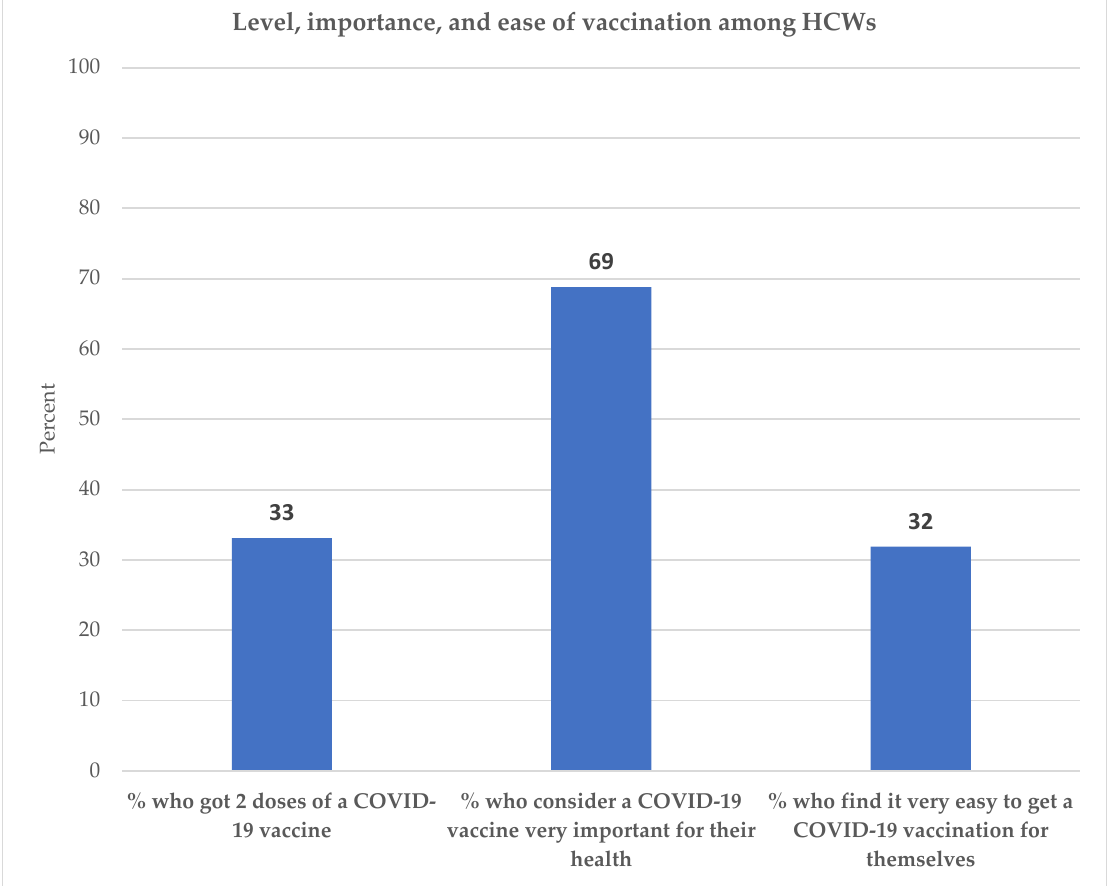
Figure 2. Percent of HCWs who got two doses of vaccine, consider vaccines important, and find them easy to get. Table 1, Column 1, shows the distribution of characteristics of the survey sample.